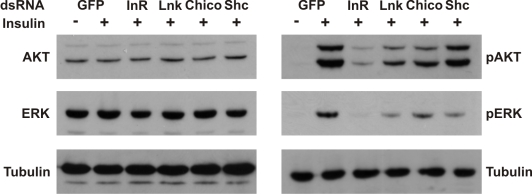

Lnk expression is required for insulin signaling and Ras/MapK signal transduction in flies.Western blot analysis of Akt and Erk-A phosphorylation in protein extracts of Drosophila S2 cells after treatment with the indicated dsRNAs before (-) and after (+) stimulation with human insulin. Knockdown of dInR, chico, or Lnk expression inhibits both Akt and Erk-A phosphorylation after insulin stimulation whereas knockdown of Shc inhibits phosphorylation of Erk-A only consistent with its role as an adapter for Ras/MAPK signaling. dsRNA against GFP was used as a negative control. Blots were probed with anti-tubulin as a loading control. Knockdowns of Lnk and chico transcripts were confirmed by Northern blot; knockdowns of dInR and Shc expression were confirmed by western blot (data not shown).